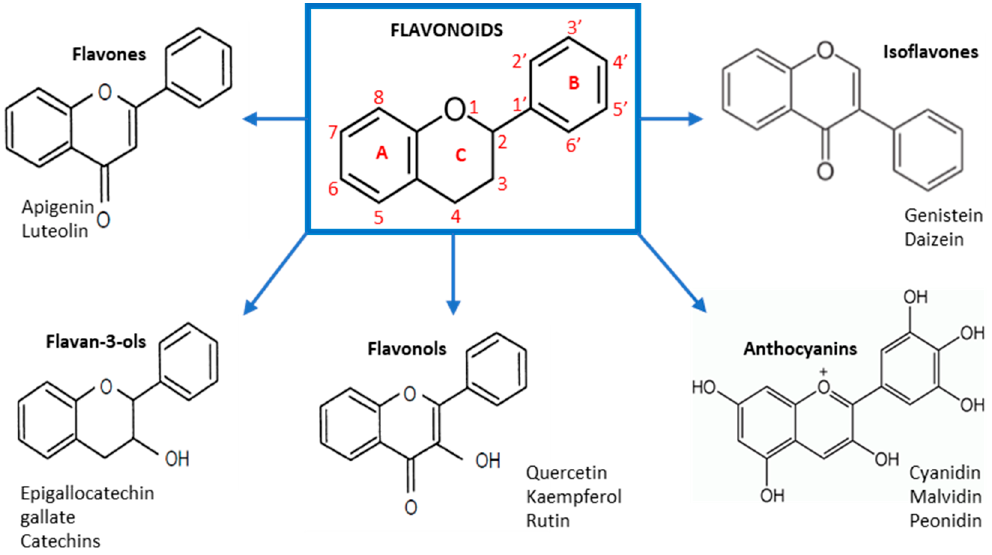
Figure 1. The chemical structures of some of the most relevant flavonoids belonging to the above- mentioned